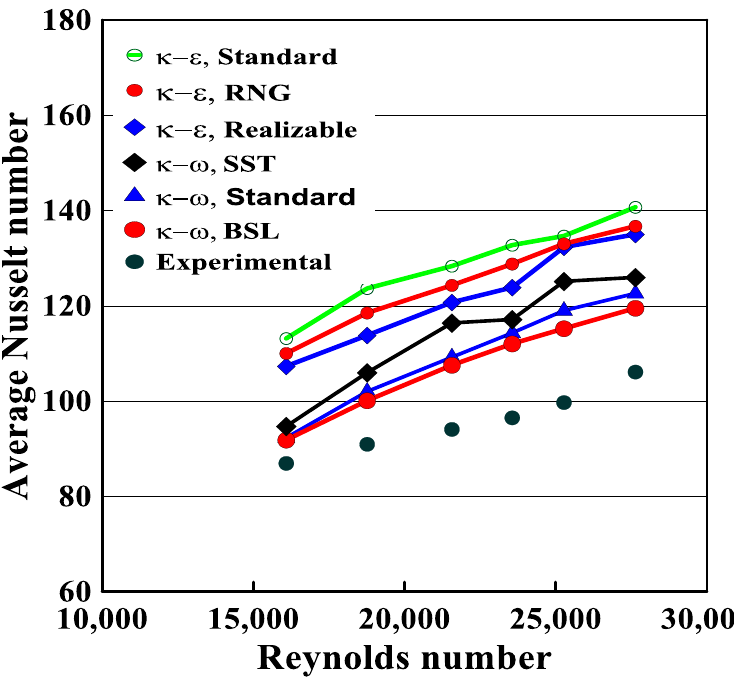
Figure 4. Model selection and validation with experimental results (setting 3), Refaey et al. [14].